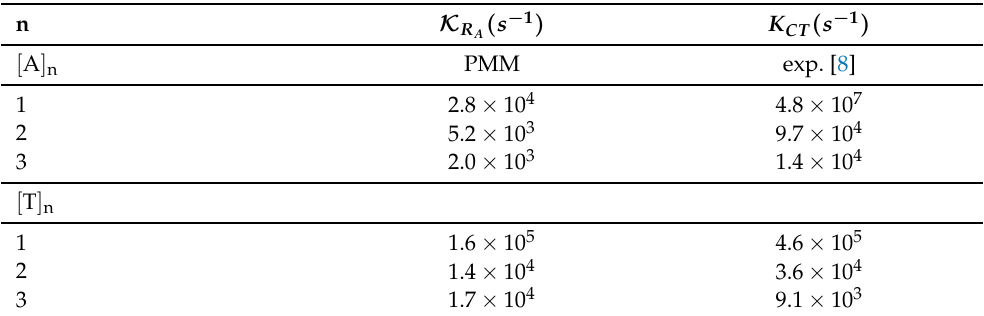
and the experimentally measured A – [ A ] n –G 3 and G . + – [ T ] n –G 3 sequence 2 2 the relative standard error is about 30 per cent of the A